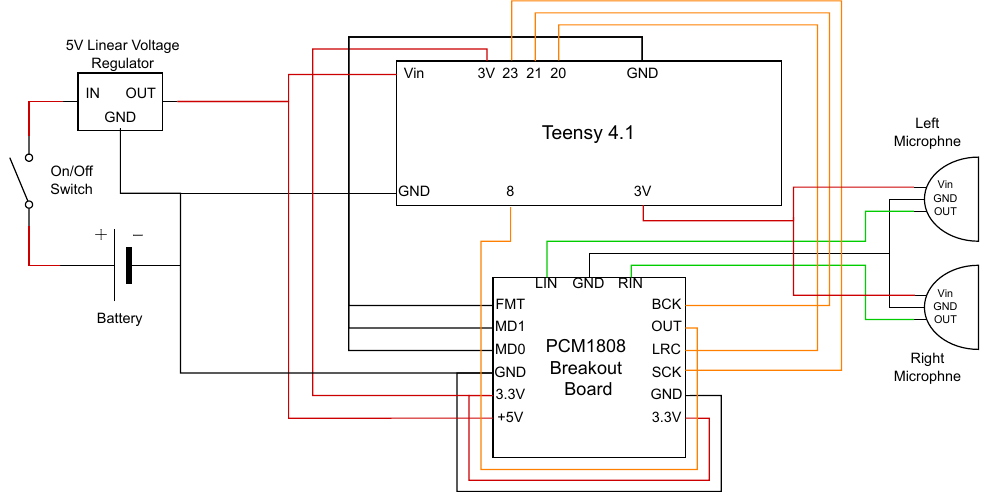
Figure 3. Block diagram of the airspeed instrument. Wires carrying power are colored red, ground wires are black, wires carrying analog signal are green and digital signal wires are